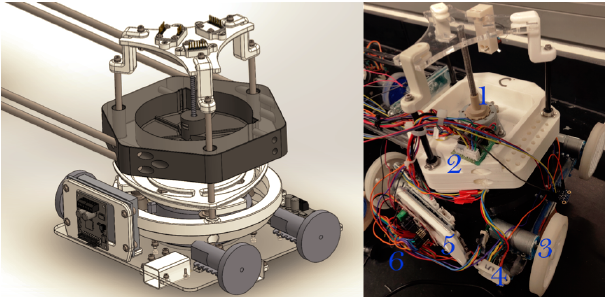
Figure 4. Mantis ’s module C. 1. Linear actuator, 2. speed driver for the linear actuator, 3. locomotive mechanism, 4. distance sensor, 5. speed controller of the blower, 6. speed controller of the locomotive actuators, and 7. inertial measurement unit